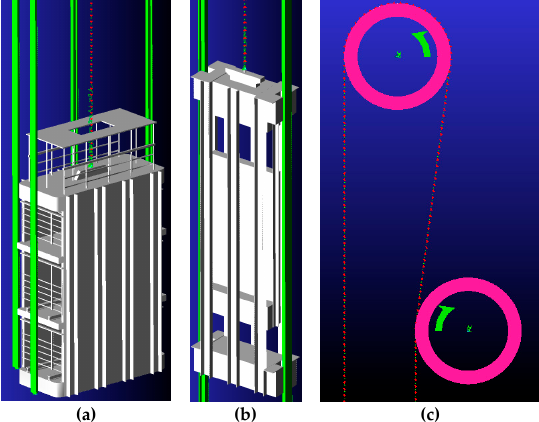
Figure 2. Dynamic model of the friction hoist. ( a ) Cage; ( b ) Balance hammer; ( c ) Pulleys.